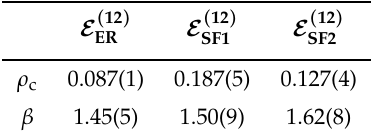
Table 5. Estimates of fit parameters for ˜ T cons